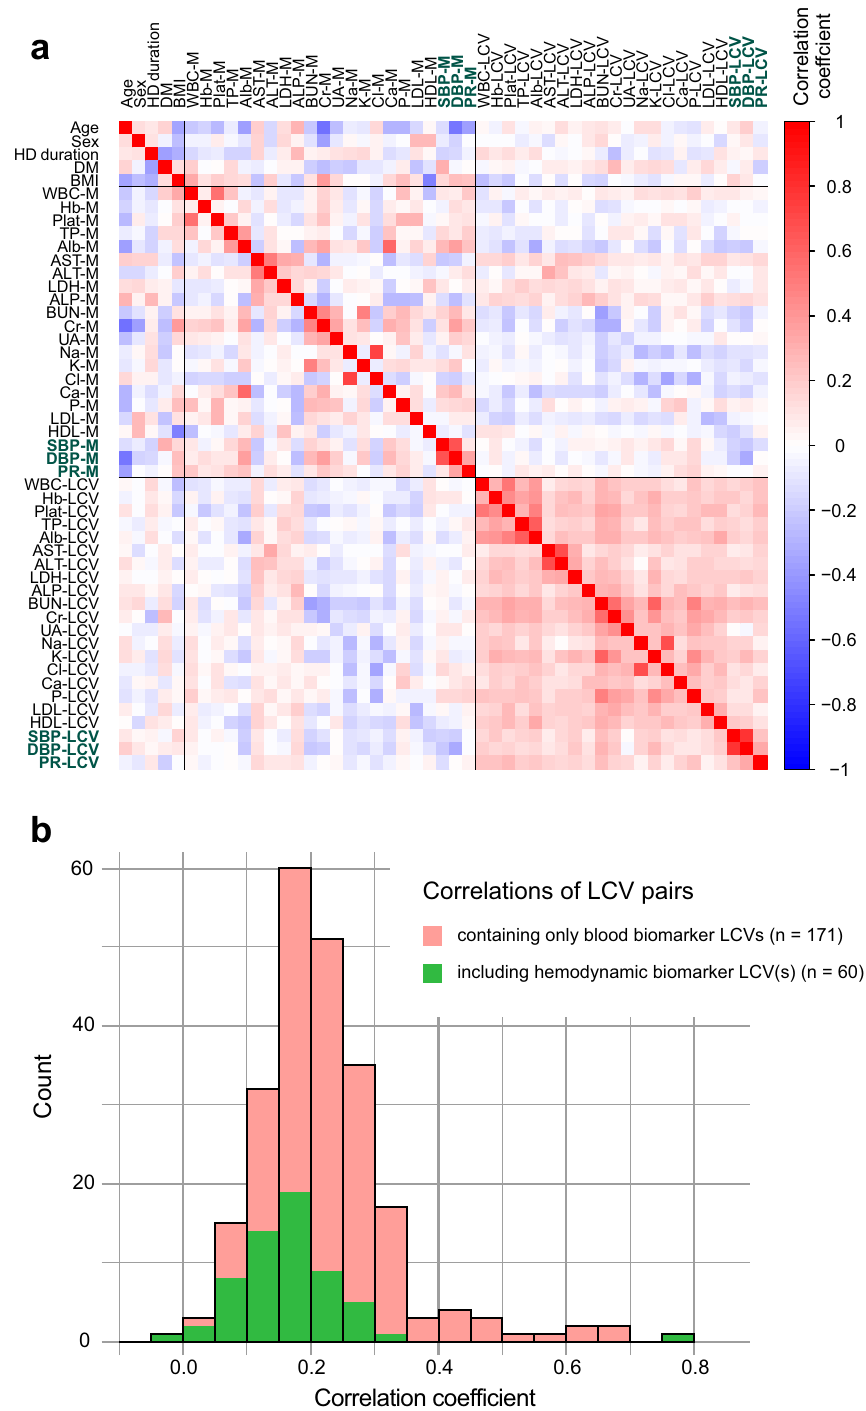
Figure 2. Correlations among the demographic parameters, biomarker levels, and their variabilities. ( a ) The correlation matrix in Supplementary Table S1 is shown as a heatmap. The sign and strength of the correlation coefficient are displayed by the color and its density, respectively. HD hemodialysis, DM diabetes mellitus, BMI body mass index. ( b ) Distribution of the 231 correlation coefficients among the biomarker LCVs is represented as a histogram. Among them, biomarker pairs including at least one hemodynamic biomarker are shown in